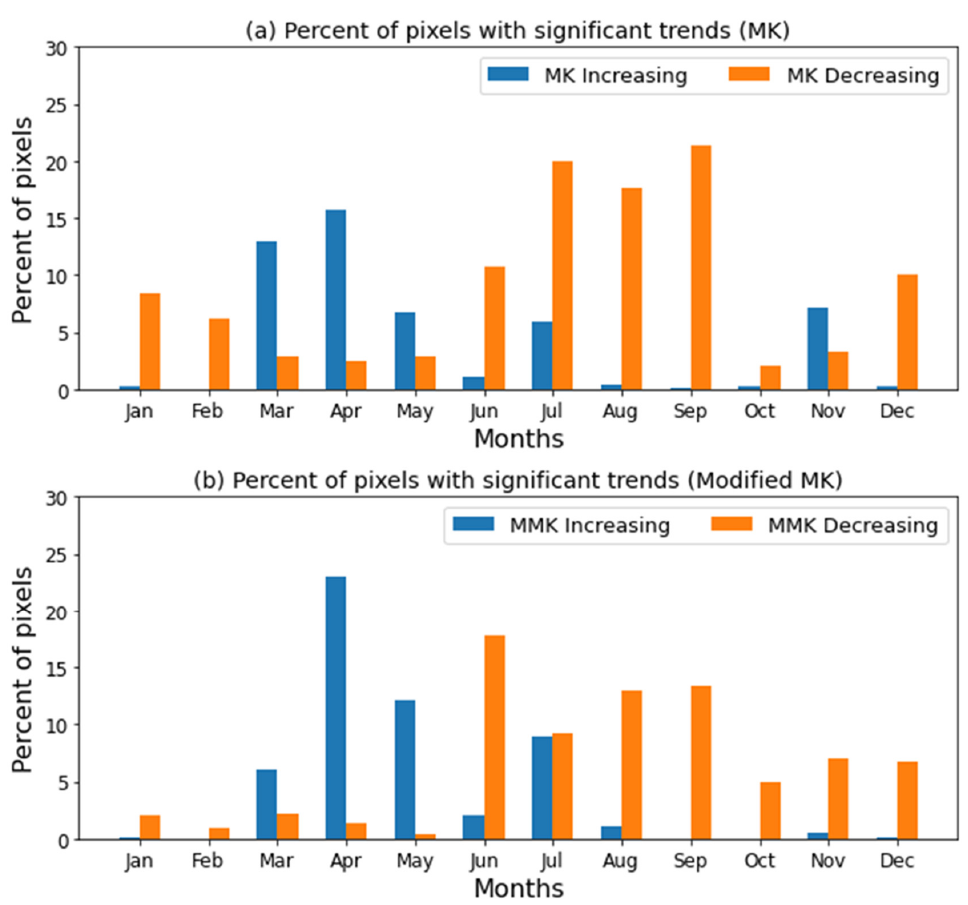
Figure 4. Percentage of pixels with significant increasing and decreasing